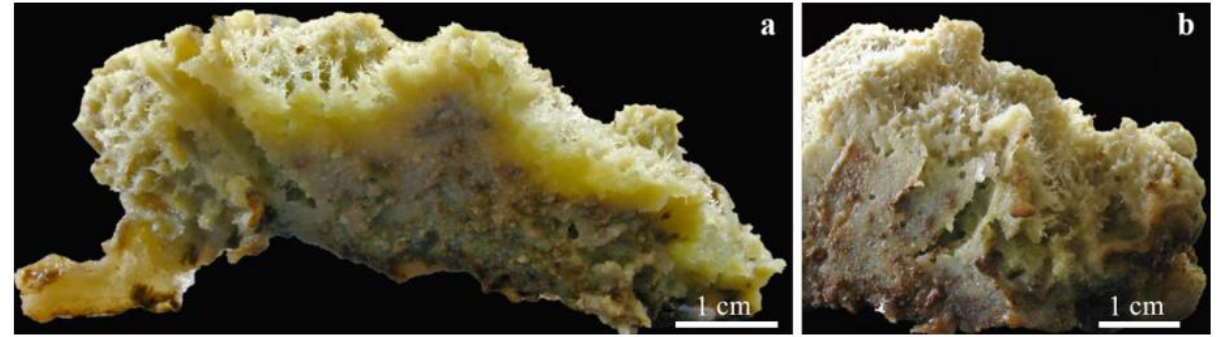
Figure 4. Corvospongilla siamensis morphology (Pong River, Lower Mekong). ( a , b ) Heterogeneous microhabitat at the sponge irregular surface with ridges and large tube-like exhalant aquiferous aperture openings.